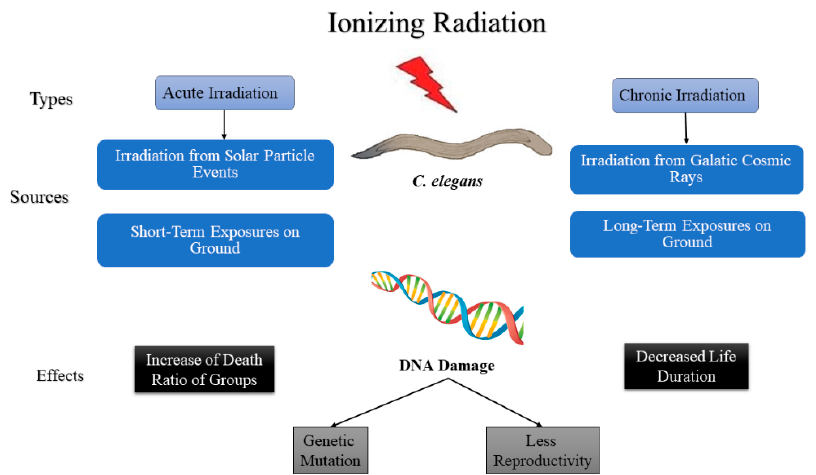
Figure 3. Diagram describing the effect of ionizing radiation on C. elegans.